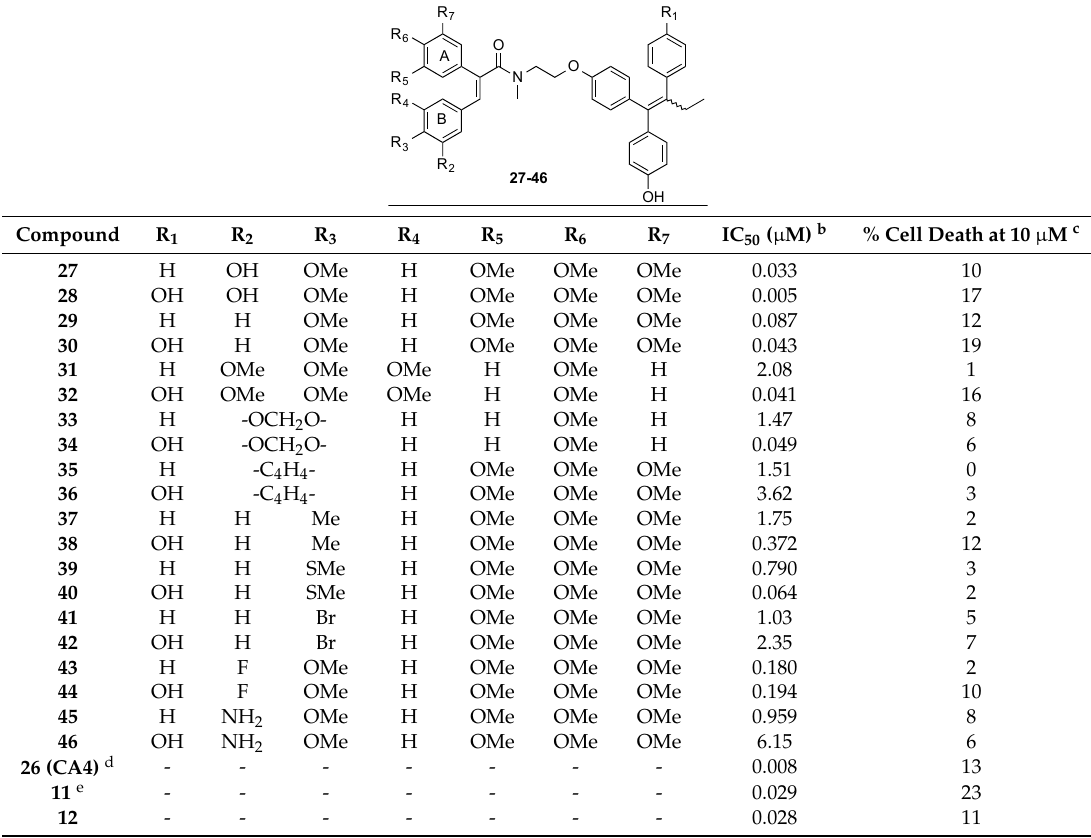
Table 2. Antiproliferative effects of conjugate compounds 27 – 46 in MCF-7 human breast cancer cells a .